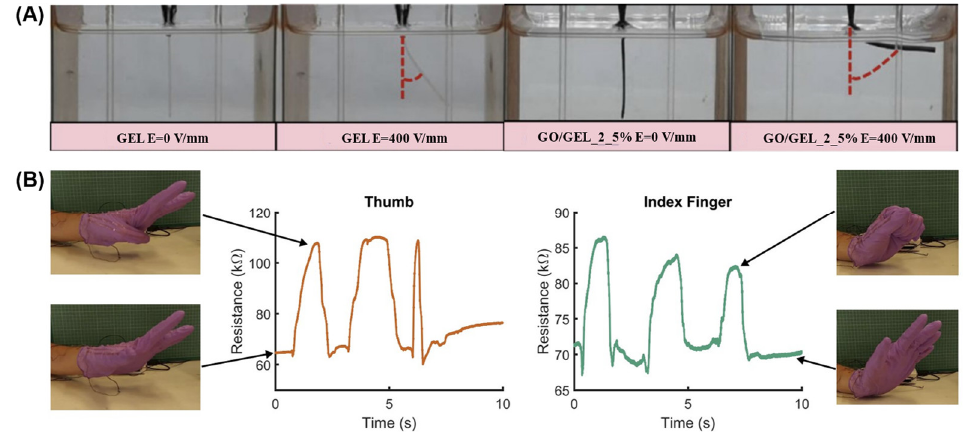
Figure 4. Electromechanically-stimulated gelatin actuators. ( A ) The degree of deflection and the electrode distance of 4 cm for gelatin actuators or graphite/gelatin actuators with increasing electric field strength [44]. ( B ) Gelatin can also be used as a sensor. All five fingers of the glove are 3D printed with gelatin sensor networks and can return separate strain responses [28]. (Images ( A , B ) are licensed under CC BY 4.0 (http://creativecommons.org/licenses/by/4.0/ (accessed on 30 October 2022))).